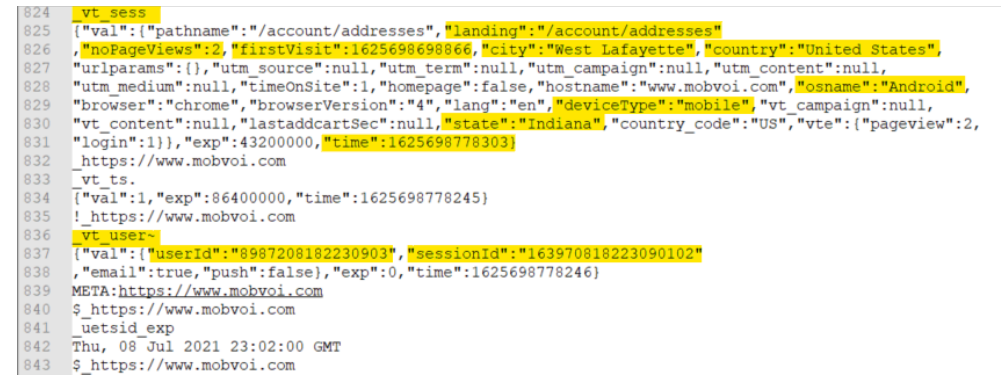
Figure 28. Reduced and formatted log that is generated when the user visited the Addresses section of the Mobvoi